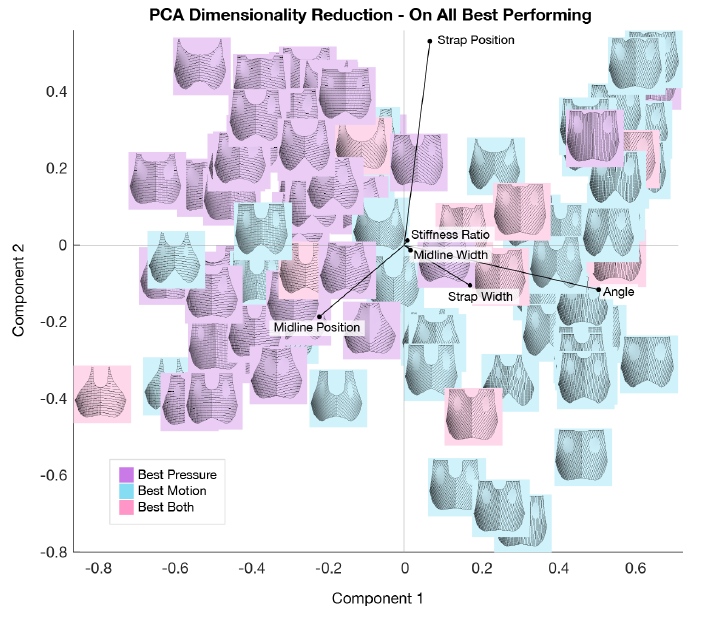
Figure 19. Visualization of principal component analysis of filtered